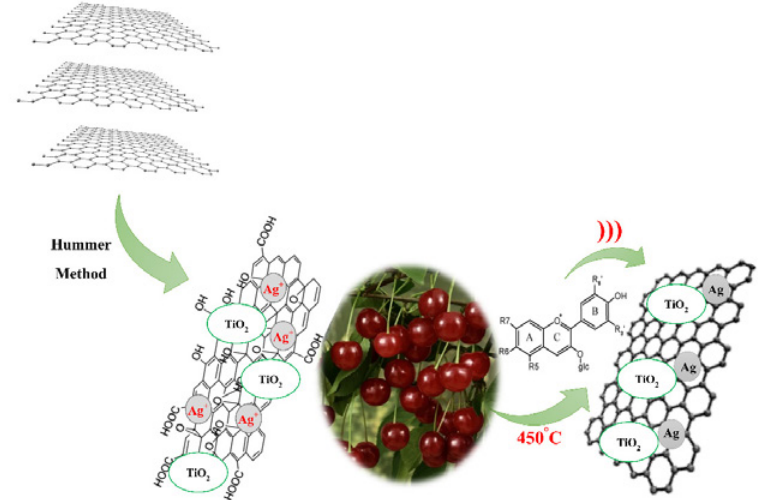
Fig. 1. Green synthesis procedure of Ag-TiO